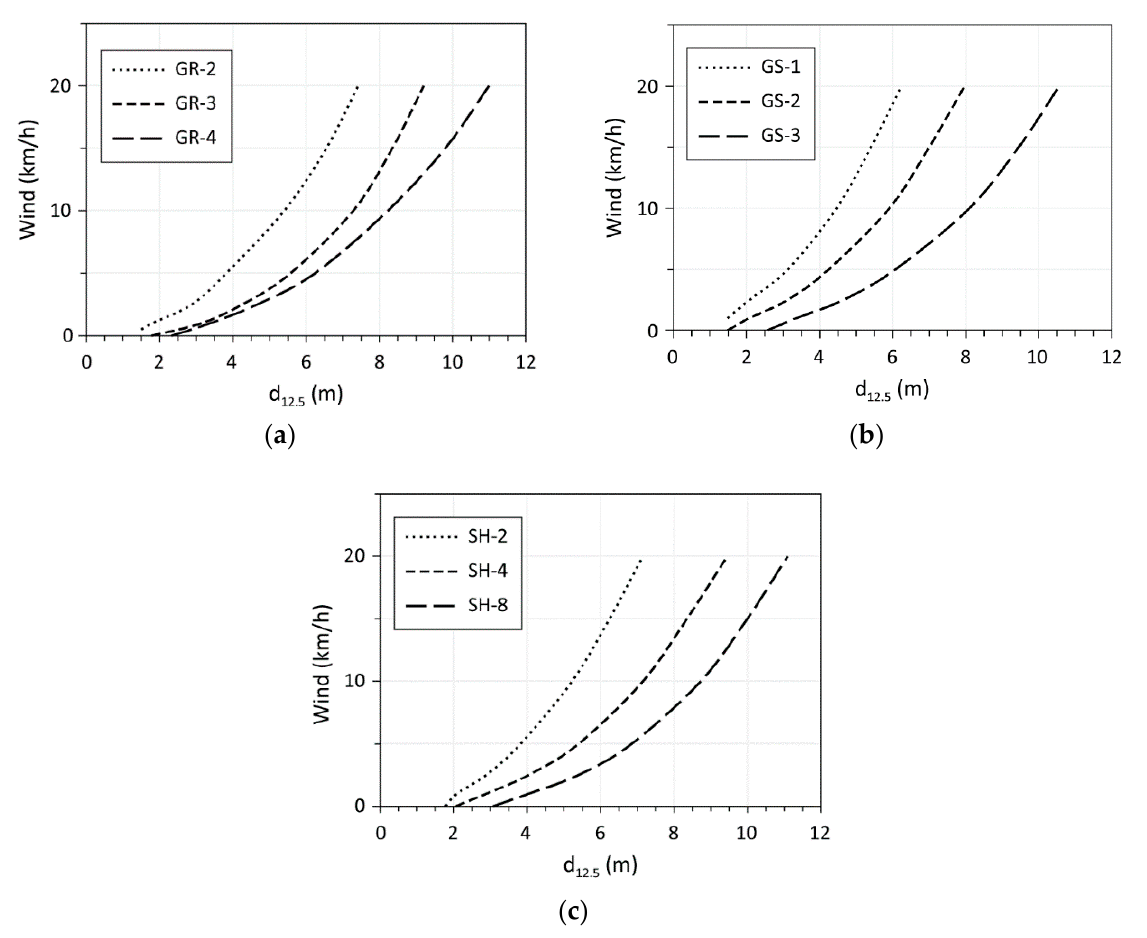
Figure 6. Safe separation distances as a function of wind speed at very low MC (D1L1) for each fuel model: ( a ) Grasses, ( b ) Grass-Shrubs, ( c ) Shrubs.